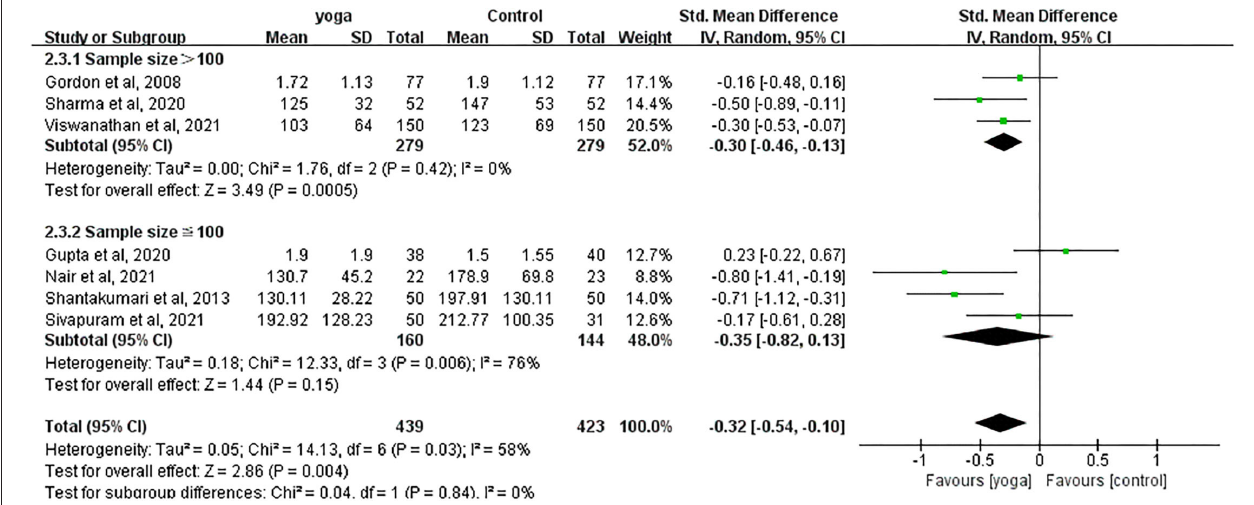
FIGURE 12 | Forest plots of the subgroup analysis on TG.